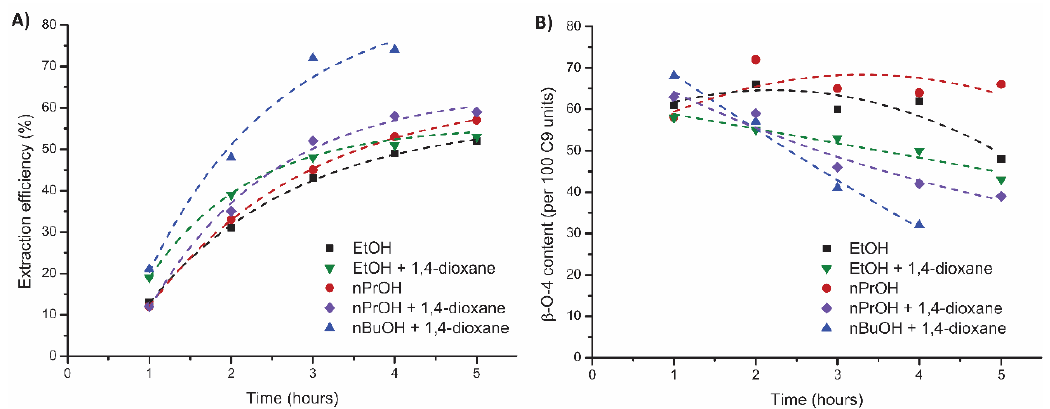
Figure 6. Influence of alcohol on the mild organosolv extraction (80:20 alcohol/H 2 O *, 0.18 M H 2 SO 4 , 120 °C, 5 h) on ( A ) extraction efficiency (corrected for alcohol incorporation as determined by 2D HSQC) and ( B ) total β-O-4 content as determined by 2D HSQC. *W hen 1,4-dioxane was used, an 80:15:5 alcohol/H 2 O/1,4-dioxane ratio was applied.